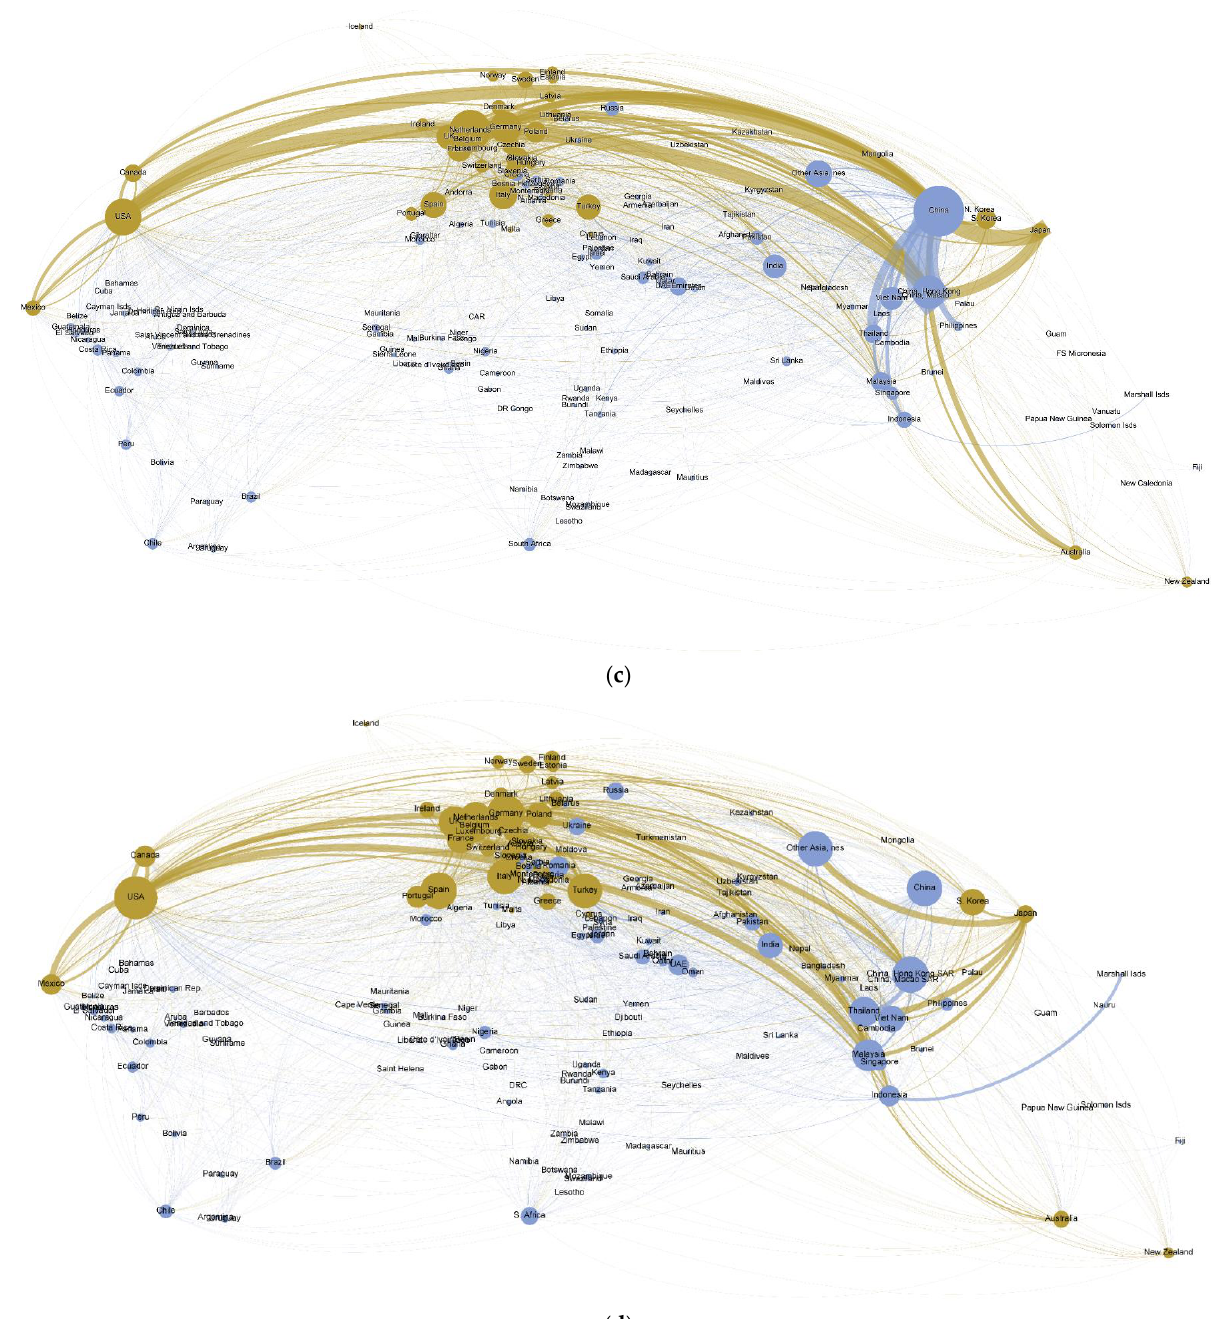
Figure 3. ( a ) Global trade network of plastic waste, 1996. ( b ) Global trade network of plastic waste, 2006. ( c ) Global trade network of plastic waste, 2016. ( d ) Global trade network of plastic waste, 2019. In 2006, China became the largest recipient of plastic waste, with Hong Kong SAR